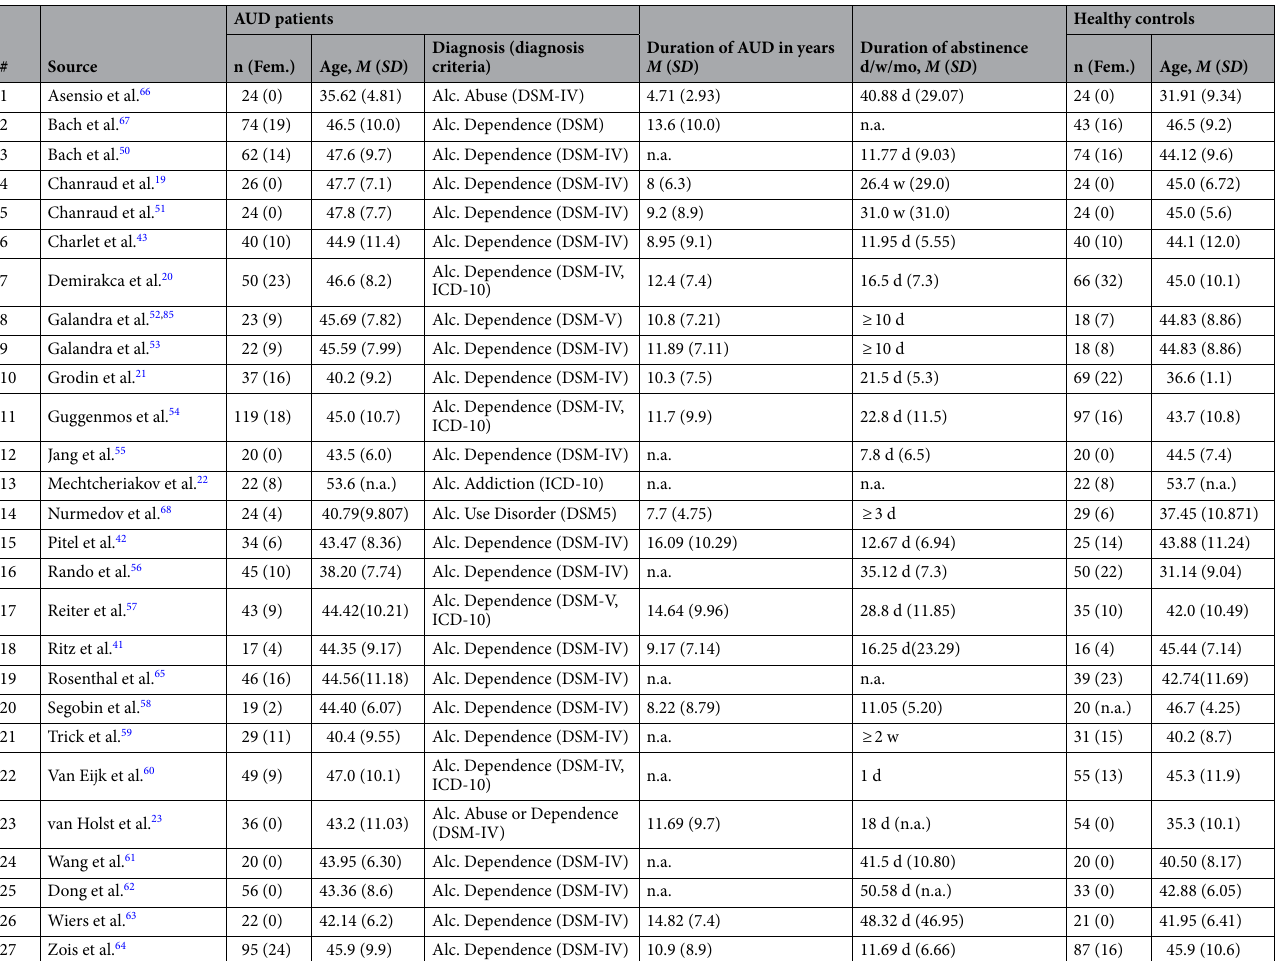
Table 1. Demographic and clinical sample characteristics of the studies included in the ALE meta-analysis. AUD = alcohol use disorder, Fem. = females, d/w/mo = days/weeks/months, n.a. = information not